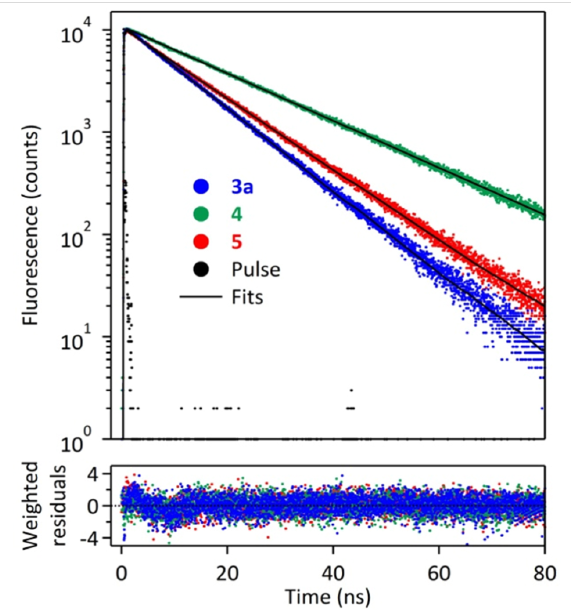
Figure 3: Fluorescence decay curves for 3a and 5 in chloroform and for 4 in 0.01 M PBS (pH 7.35). λ excit = 360 nm; λ em = 385, 390 and 383 nm, respectively.